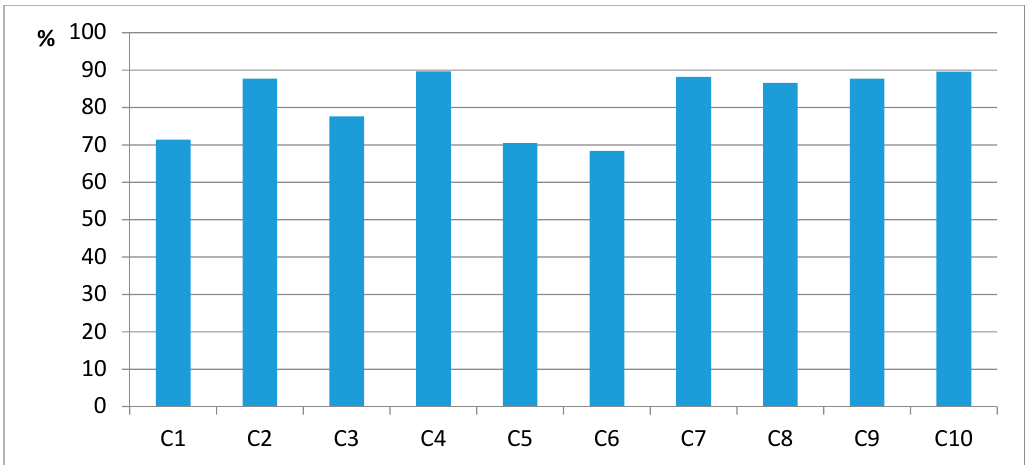
Figure 3. Germination index values for analysed composts.